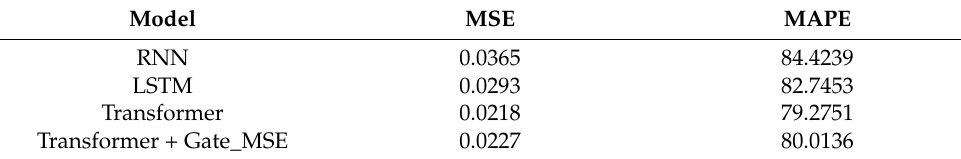
Table 1. Effect of model and loss on the